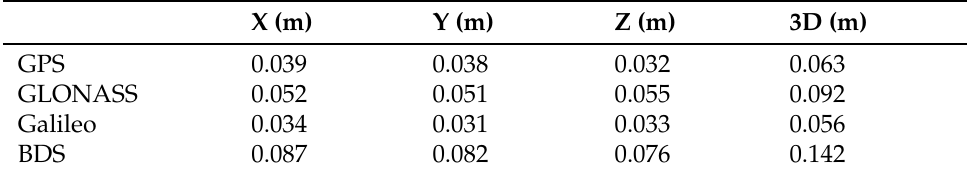
Table 3. Eleven–day mean RMS values of CLK93 products’ orbits. X